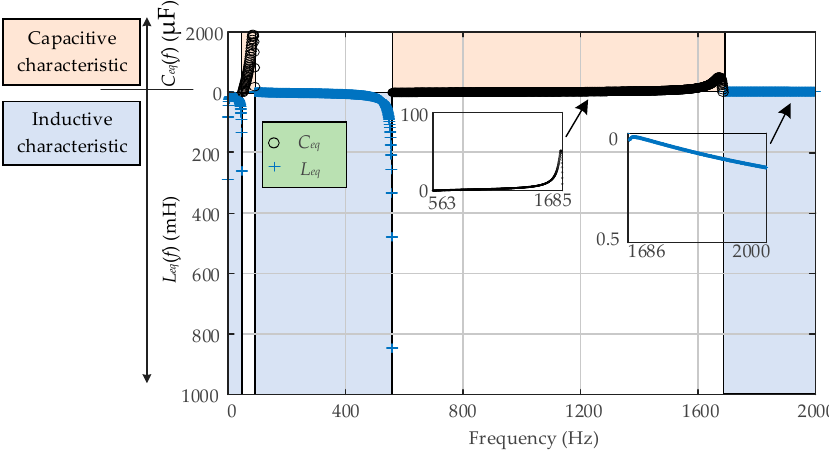
Figure 5. Effect of frequency on C eq and L eq .